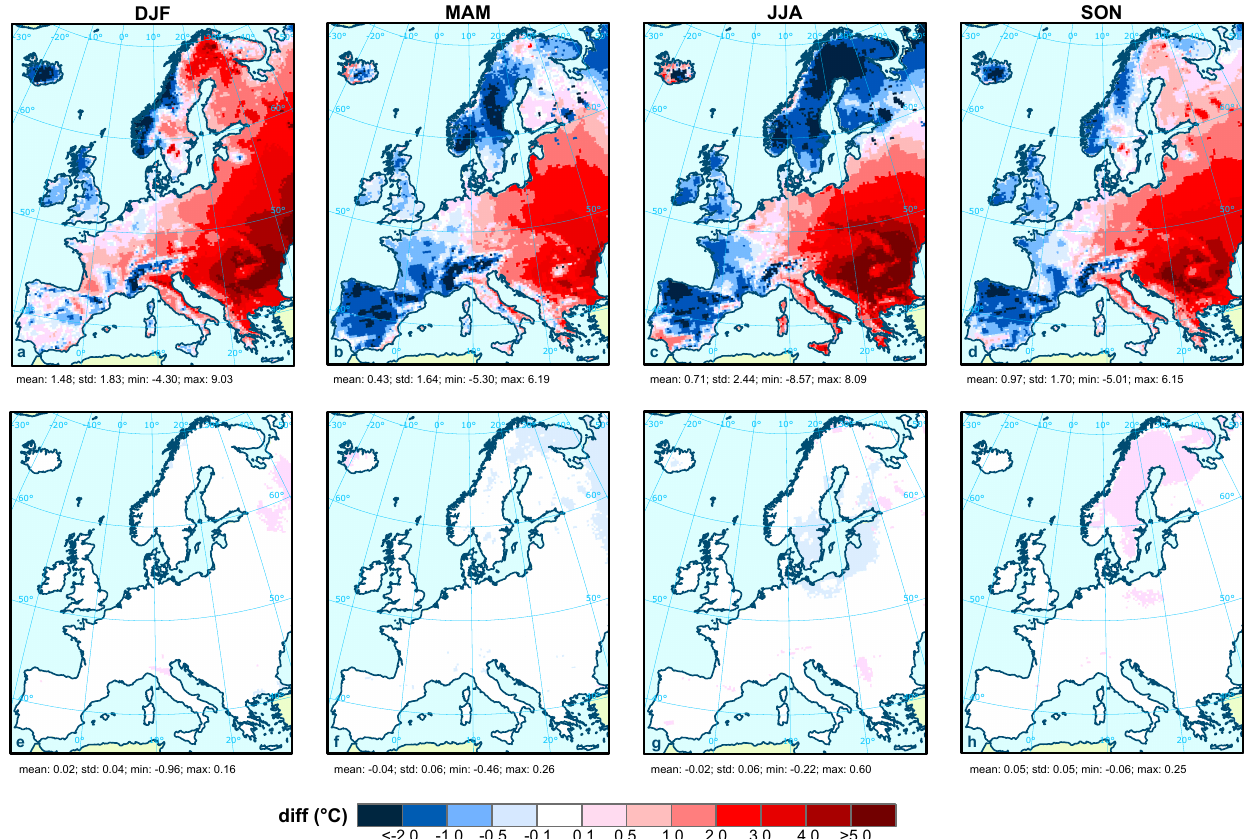
Fig. 6. Difference between HIRHAM5-ECHAM5 simulations and observations of seasonal average daily temperature for the period 1961– 1990. First row, uncorrected seasonal temperature; second row: bias corrected seasonal